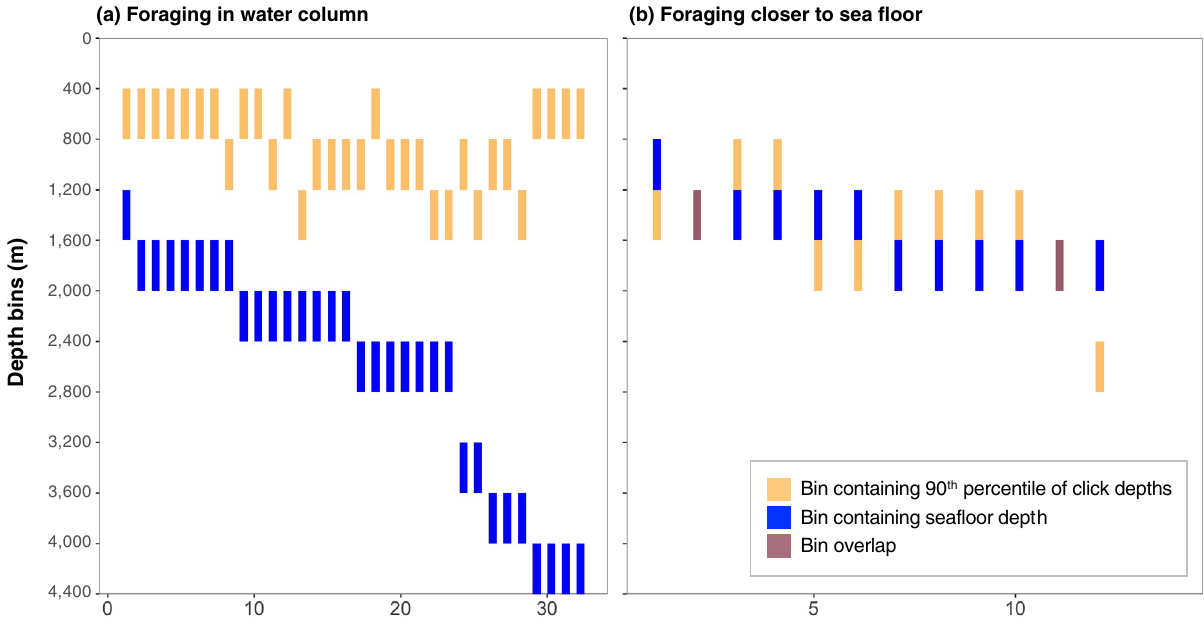
Figure 7. For the 44 events with a U shaped click depth pattern, the whale was categorized as diving in the water column if ( a ) the bin including the 90th percentile of the click depths was more than 400 m above the bin including the seafloor depth (n = 32 events) or was categorized as diving closer to the seafloor if ( b ) within 400 m of the bin including the seafloor depth (n = 12 events).